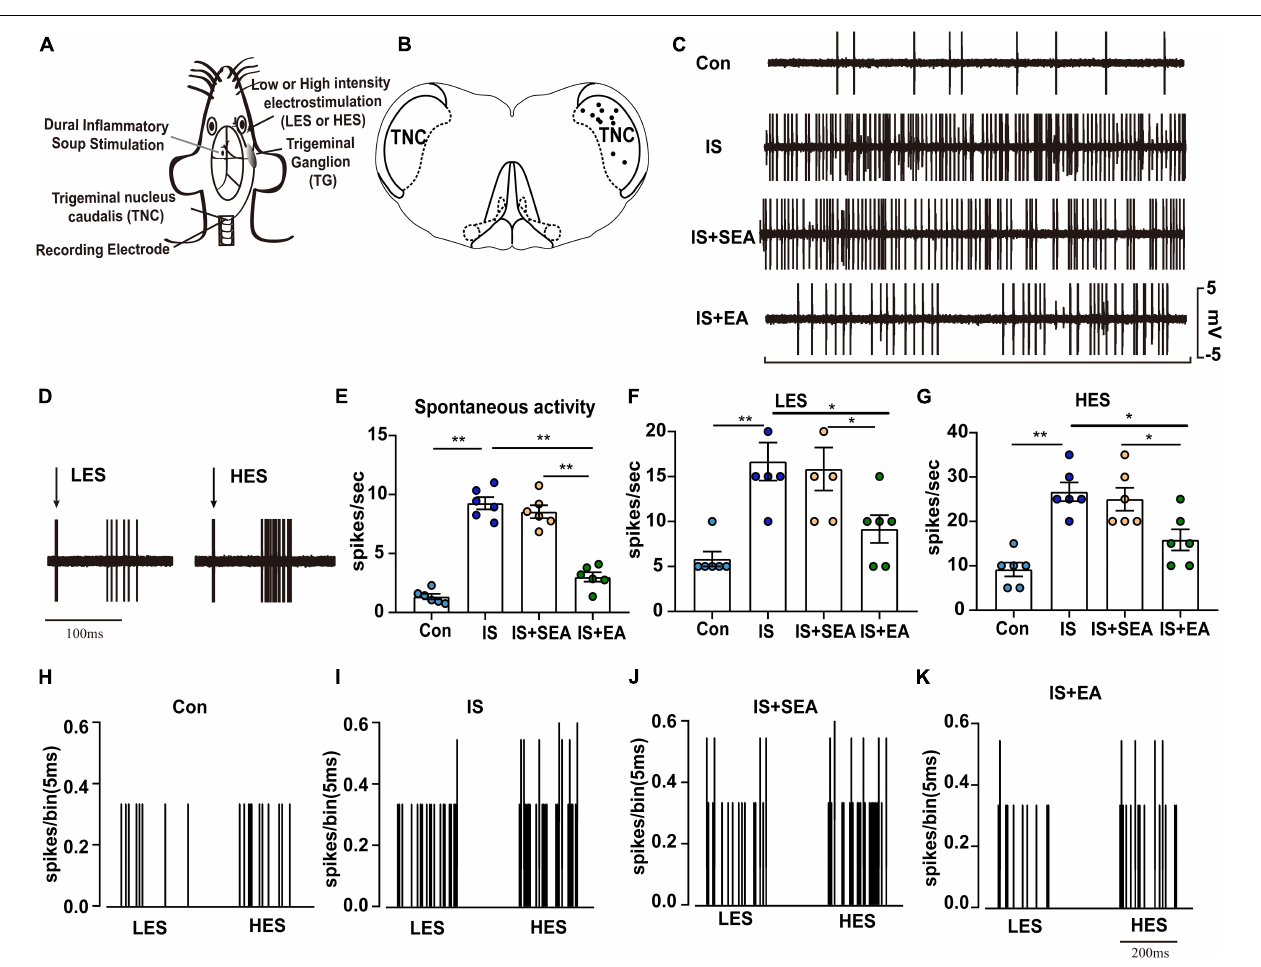
FIGURE 2 | Overview of the electrophysiological recordings and neuronal characteristics among the Con, IS, IS + SEA, and IS + EA groups. (A) Experimental setup with IS injection, recording of neurons in the TNC and percutaneous electrical stimulation. (B) The location of recording sites in the TNC from which recordings of nociceptive neurons, receiving convergent input from the dura mater and facial receptive field, were made. The locations were reconstructed from lesions ( • ) and located in laminae IV–VI. (C) Spontaneous activity was recorded for 60 s at 30 min postfinding the activated neurons for stabilization among the indicated groups. (D) An original tracing from a typical unit (second-order neurons) responding to percutaneous electrical stimulation in low [1 Tc (2 mA), LES] and high [2.5 Tc (5 mA), HES] intensity (latencies in the C-fiber range). Black arrow represents stimulus artifact. Spontaneous activity (E) , LES-evoked responses (F) , and HES-evoked responses (G) of WDR neurons recorded 2 h after the 4th IS or aCSF injection in the TCC of none manipulation (Con and IS) (H,I) , SEA (IS + SEA) (J) , or EA (IS + EA) (K) rats. When four groups were compared for electrophysiology, a Kruskal-Wallis test was used, and when only two groups were compared, a Mann-Whitney U test was used. Group values are indicated by mean ± SEM. * P < 0.05, ** P < 0.01. Tc, the stimulation intensities required to evoke neuronal activity with a conductive velocity of 0.4–2 m s − 1 , namely about 2 mA. LES, low-intensity electrostimulation; HES, high-intensity electrostimulation; WDR, wide-dynamic range; TG, trigeminal ganglion; TNC, trigeminal nucleus caudalis; EA, electroacupuncture; IS, inflammatory soup; aCSF, artificial cerebrospinal fluid; SEA, sham electroacupuncture; Con,